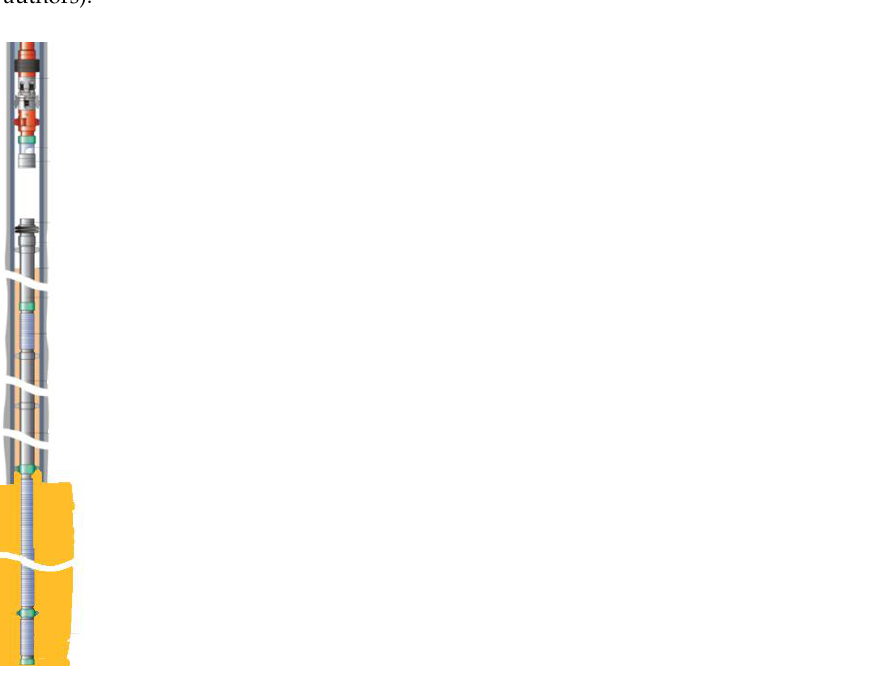
Figure 9. Example of the unsatisfactory condition of a gas well at its mouth, (source: elaborated by authors).